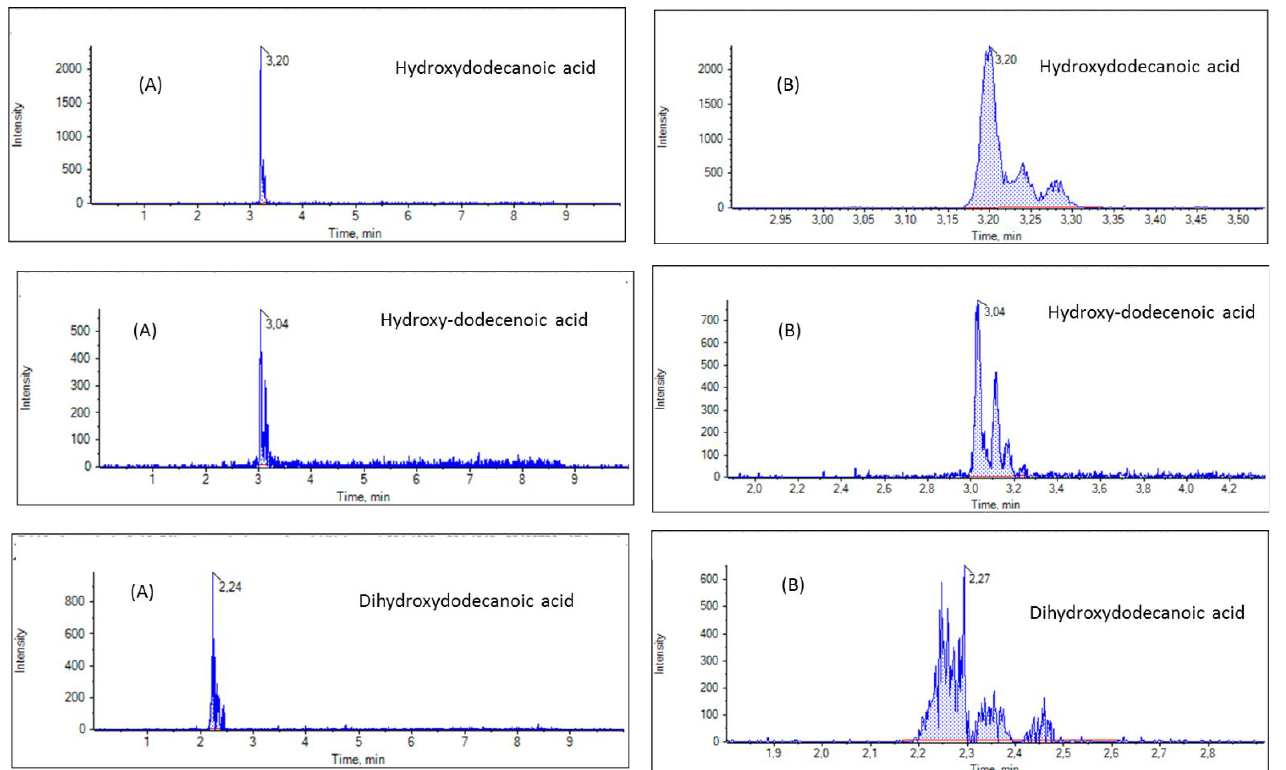
Figure 6. EICs of hydroxytetradecanoic acid ( A ) and zoom ( B ) in a representative RJ sample. Finally, we screened our RJ samples for the existence of long-chain saturated hydroxy fatty acids (SHFAs). In 2020, we uncovered a previously unrecognized family of FAs, namely SHFAs, in milk and in human plasma, and we have demonstrated their beneficial biological effects [32]. This family consists of various regio-isomers, in particular, of pal- mitic and stearic acids, with the hydroxyl group at different positions of the long aliphatic chain. EICs of hydroxypalmitic acid ([M − H] − exact mass 271.2279) and hydroxystearic acid ([M − H] − exact mass 299.2592) in a representative RJ sample are presented in Figure